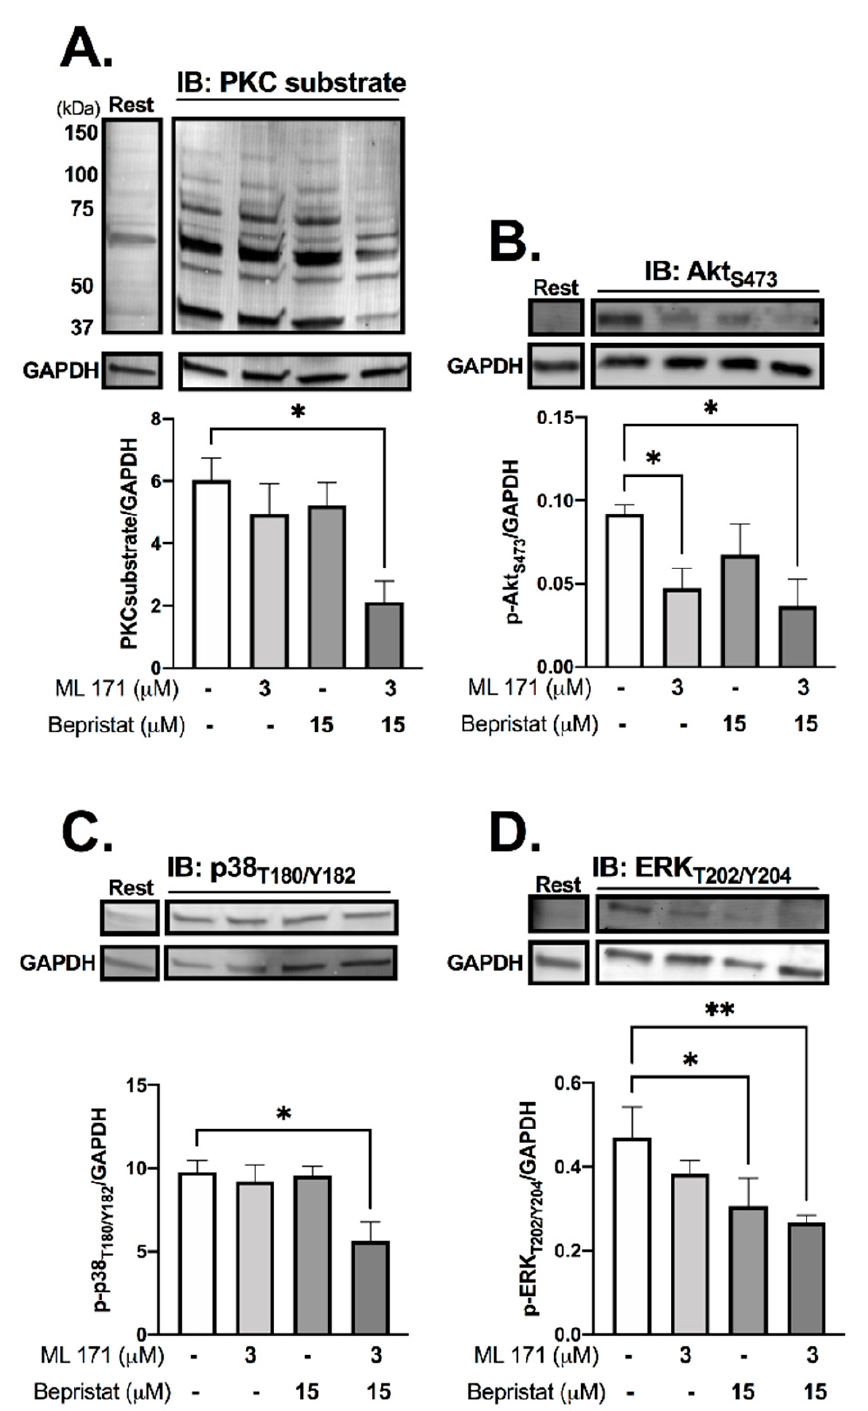
Figure 4. PDI and Nox-1 co-inhibition decreases phosphorylation of PKC substrates, Akt, p38MAPK and ERK. WP at 4 × 10 8 platelets/mL were incubated with 3 µ M ML171 and/or 15 µ M bepristat for 10 min prior to adding 3 µ g/mL Collagen. Platelets were lysed after 90 s and immunoblots performed. Samples were tested for: putative PKC substrate phosphorylation ( A ), AktS473 ( B ), p38 MAPKT180/Y182 ( C ) and ERKT202/Y204 ( D ). GAPDH was used as a control for equal loading. Representative blot is presented above of bar graphs with summary statistics. Each lane represents the condition in graph below. A basal unstimulated condition is presented (Rest). Data are representative of 3–4 independent experiments. Bar graphs show mean ± SEM and were analysed by paired one-way ANOVA and Tukey’s post-test. * p < 0.05, ** p <